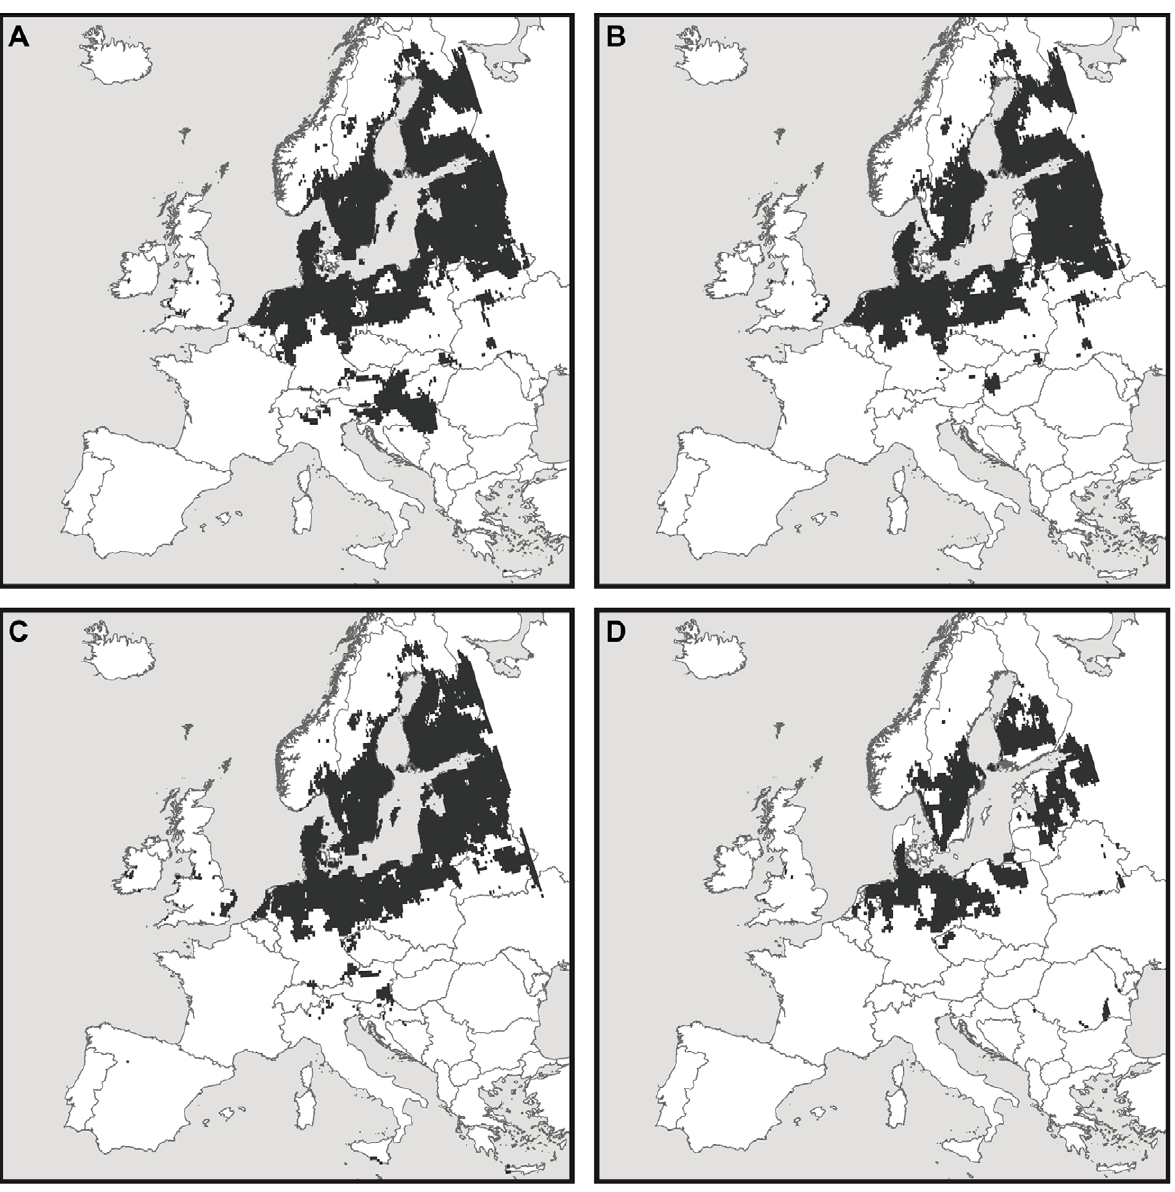
Figure 3. Projected potential future distributions of Aeshnaviridis in Europe assuming unlimited dispersal. A) A. viridis without interaction, occurrence threshold: 0.02, AUC: 0.93. B) Overlapping area of the potential future distributions of A. viridis and S. aloides ,